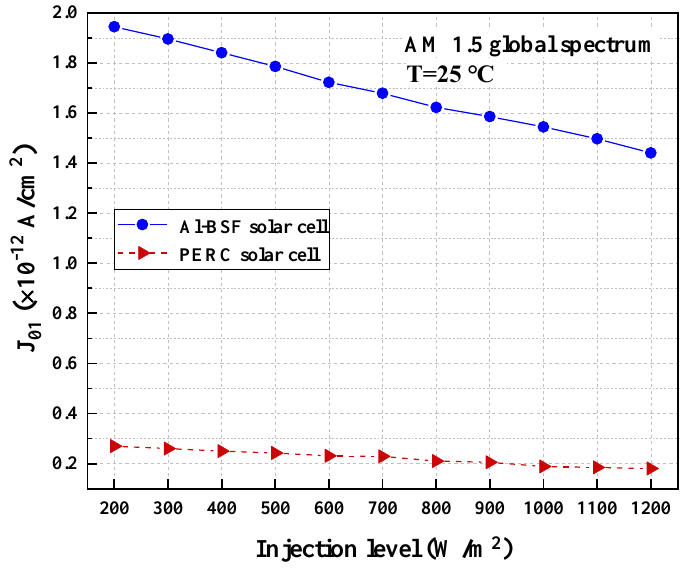
Figure 5. J 01 versus injection level for an Al-BSF solar cell and a PERC solar cell at 25 °C and AM1.5G.